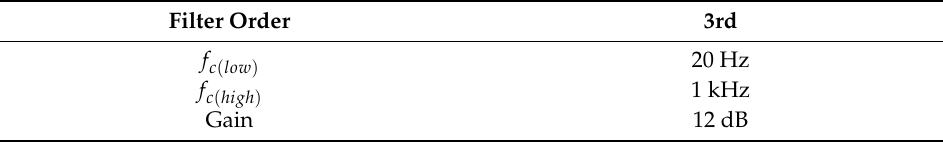
Table 11. Bandpass filter specifications.